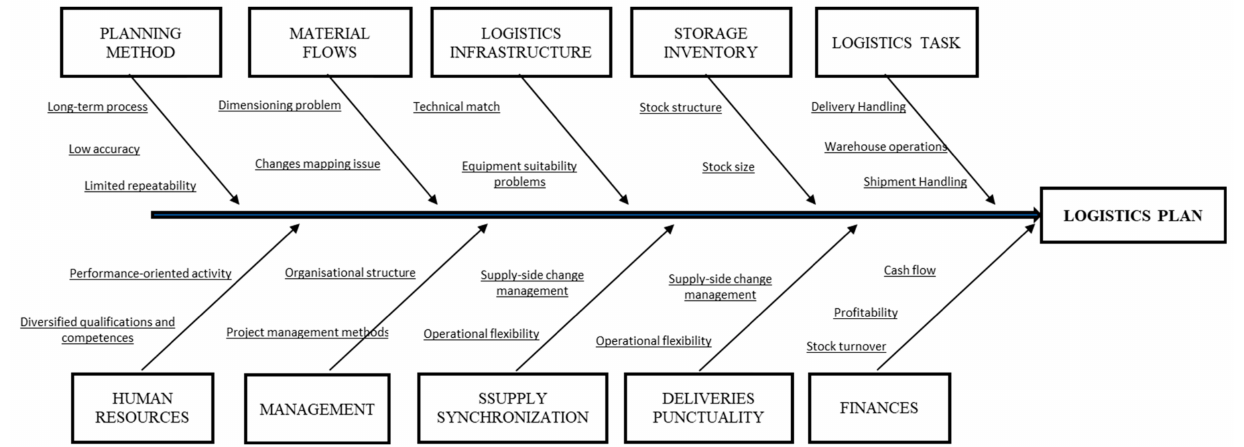
Figure 6. Cause and effect relationship in the evaluation of the logistical planning process using the PL9A